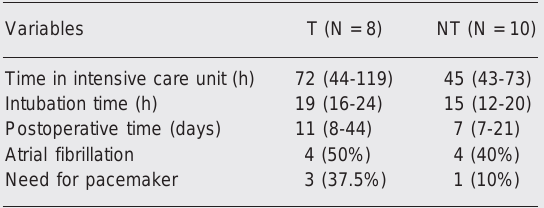
Table 3. Clinical endpoints and postoperative complications of patients treated with triiodothyronine and controls.